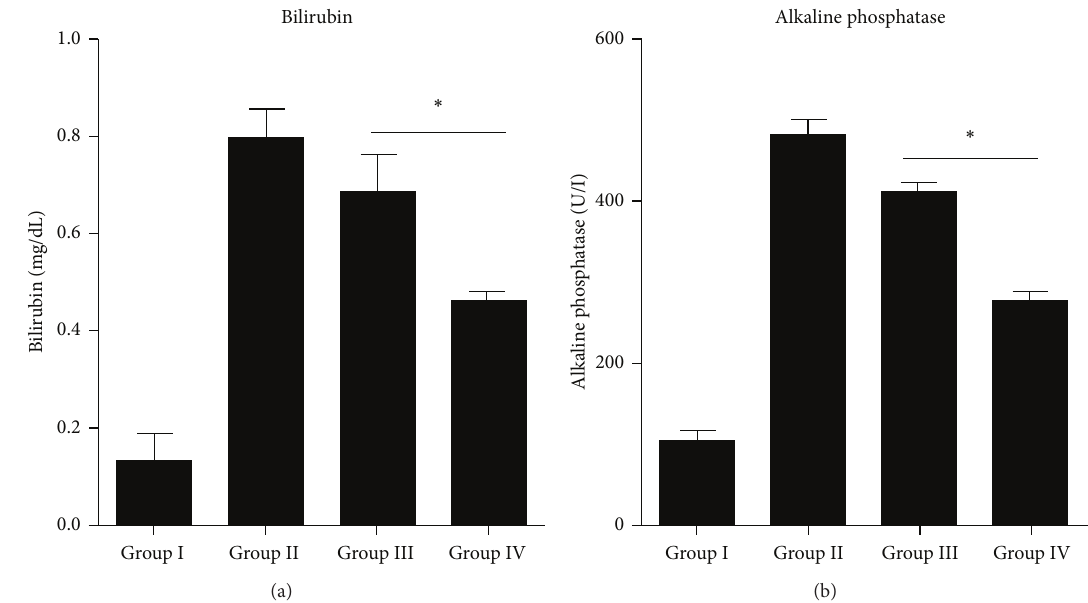
Figure 8: Functional analysis after MSCs transplantation: (a) bilirubin, (b) alkaline phosphatase; levels in Groups I, II, III, and IV after 3 weeks of transplantation. ∗ P value < 0.05 was considered significant.